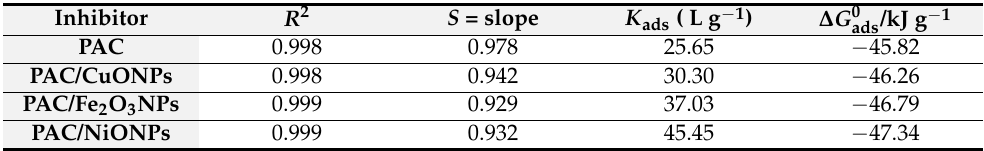
Table 3. Adsorption parameters derived from Langmuir model for C-steel in molar HCl for PAC /MONPs at 50 ◦ C using PDP